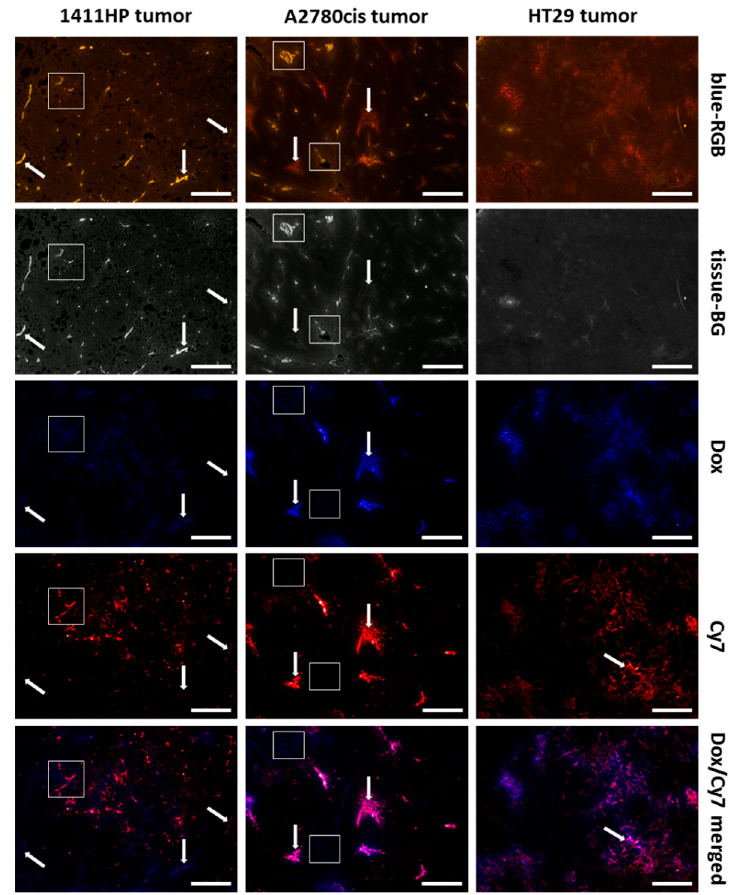
Figure 6. Patterns of intratumoral distribution 24 h after injection of the pHPMA-Dox-Cy7 conjugate. Depicted are images of the same area, respectively, generated under blue fluorescent light (upper row) and after spectral dependent isolation of signals of the tissue background (second row) of Doxorubicin (third row) and Cy7-labeled polymer carrier (fourth row) and as merged version of both (fifth row). In the 1411HP tumor type (left column), combined signals of Dox and polymer carrier are frequently associated with vessel structures (arrows and square). The A2780cis tumor type (middle column) is characterized by intense combined signals of Dox and polymer associated with specific pre-damaged tissue structures (arrows), whereas areas of large intact vessels show pure Dox signals (squares). In the HT29 tumor type (right column), intense polymer-derived signals are confined to the specific septal structures (arrows), whereas Dox-derived signals appear to be in between. (Scale bar: 500 µm).